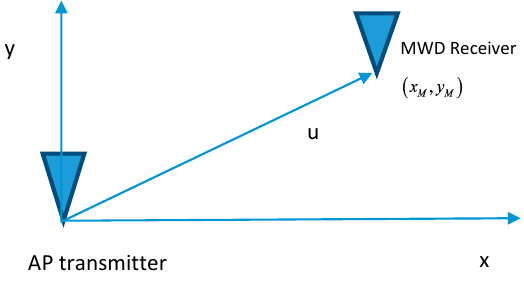
Figure 3. Two dimensional wireless link.